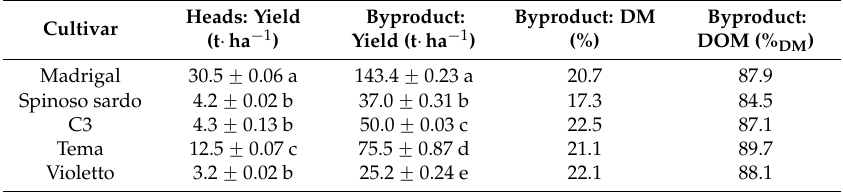
Table 2. Agronomic features of the five cultivars (heads and byproduct yields are mean values ˘ standard deviation of four replicates). Means in columns followed by different letters differ ( p <